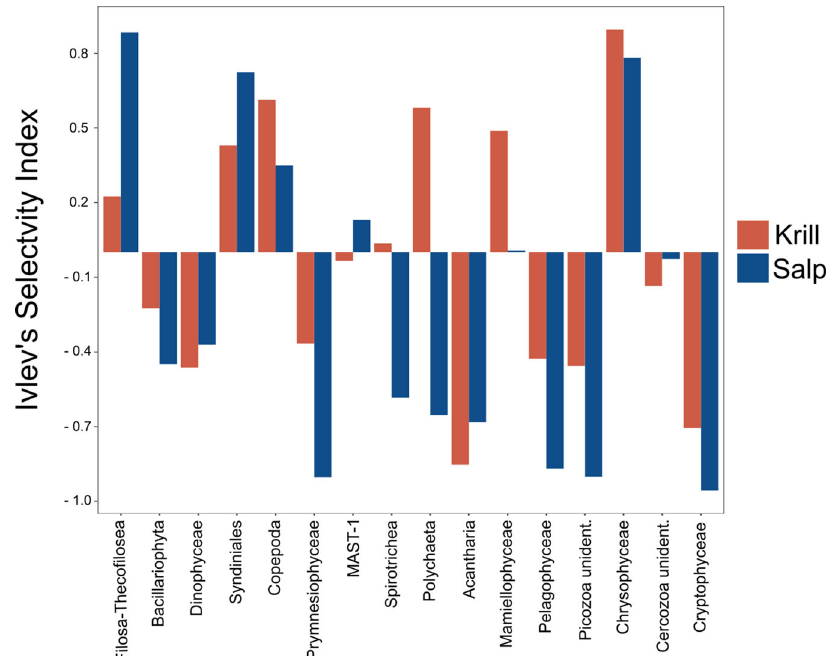
Fig. 4 Feeding selectivity of krill and salps. Ivlev ’ s selectivity index was calculated based on the relative abundance of the 18S sequencing libraries of the plankton community sampled from the chlorophyll maximum layer ( n = 10) and the stomach contents of krill and salps ( n = 61 and 60, respectively). A selectivity index of + 1 indicates preference of a prey taxon, while an index of – 1 indicates avoidance. Selectivity of krill is depicted by red bars, salps selectivity by blue Table 2). There was no signi fi cant effect of sex or length for both species.